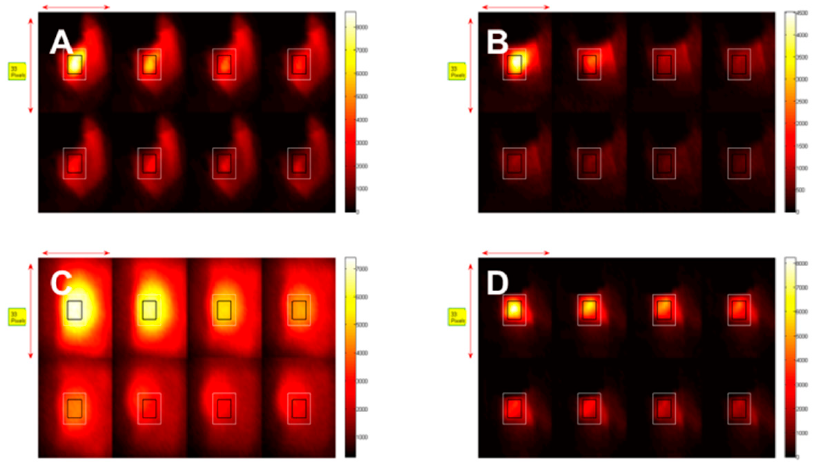
Figure 4. In vivo photobleaching of the CD in ( A ) HPPH-CD ( 8 ), ( B ) HPPH 2 -CD ( 9 ), ( C ) HPPH-Cypate ( 10 ) and ( D ) HPPH 2 -Cypate ( 11 ) conjugates in Colon26 tumors implanted in BALB/c mice. All conjugates were irradiated at 665 nm, after 24 h post-injection and treated at a fluence and fluence rate of 135 J/cm 2 and 75 mW/cm 2 . Concurrently fluorescence images were taken (wavelength detection > 830 nm) at various treatment times up to 30 min, the total treatment